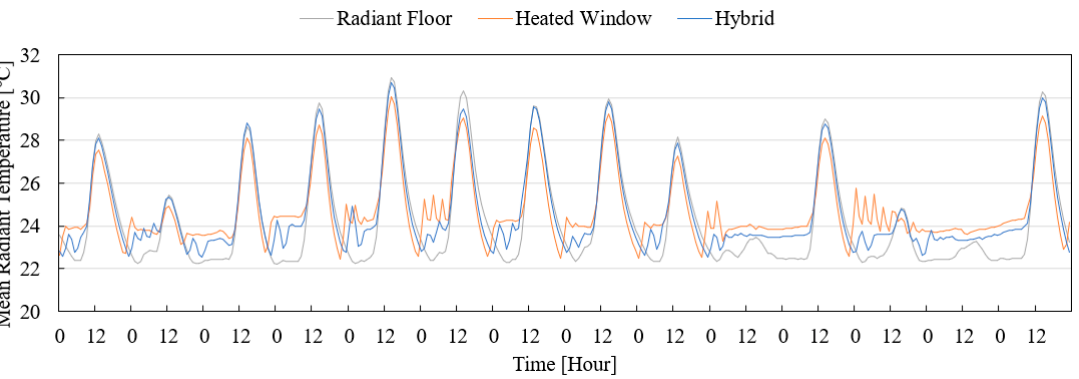
Figure 10. Mean radiant temperature of the glass zone of each model under the typical floor condi-